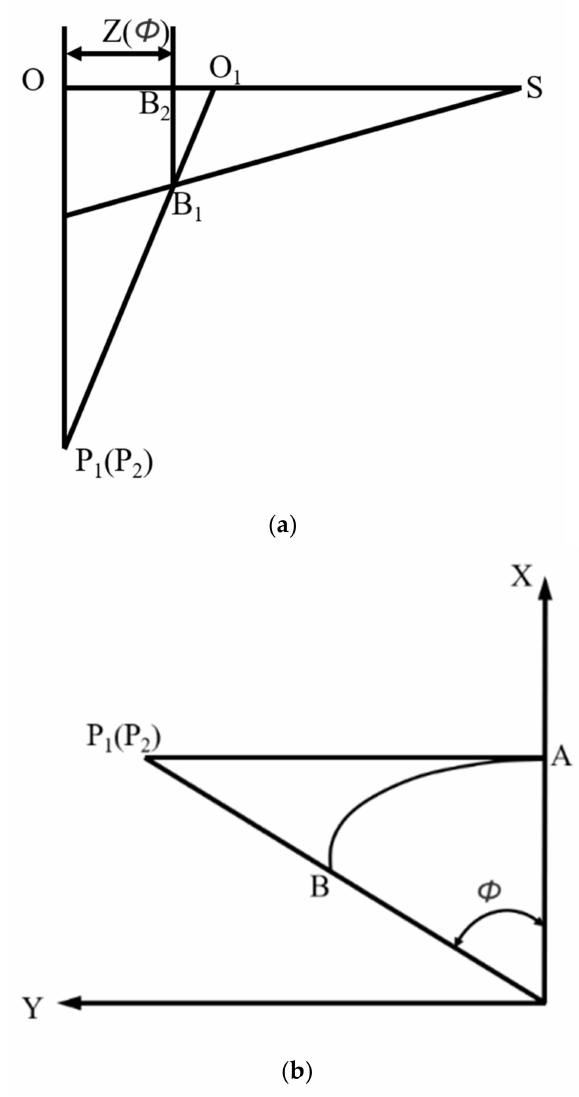
Figure 5. Auxiliary schematic diagram of plunger ball head B 1 ( a ) The plane of the plunger axis ( b ) The intersection of the vertical line and the moving